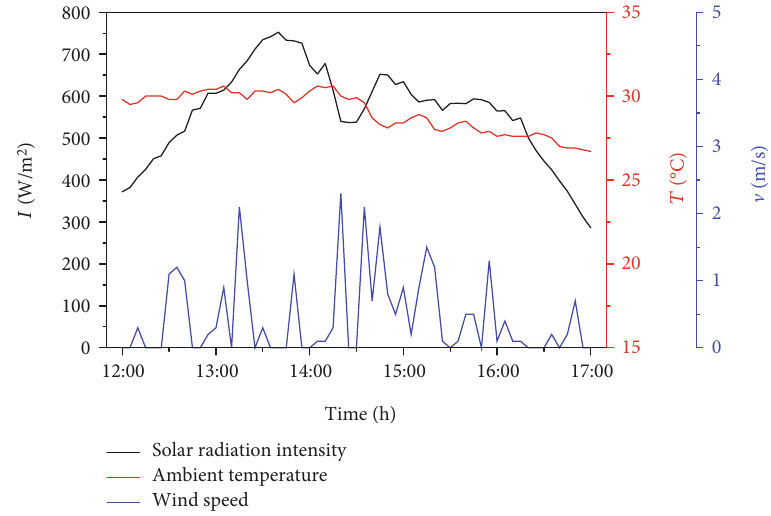
Figure 5: The curve of solar radiation intensity and ambient